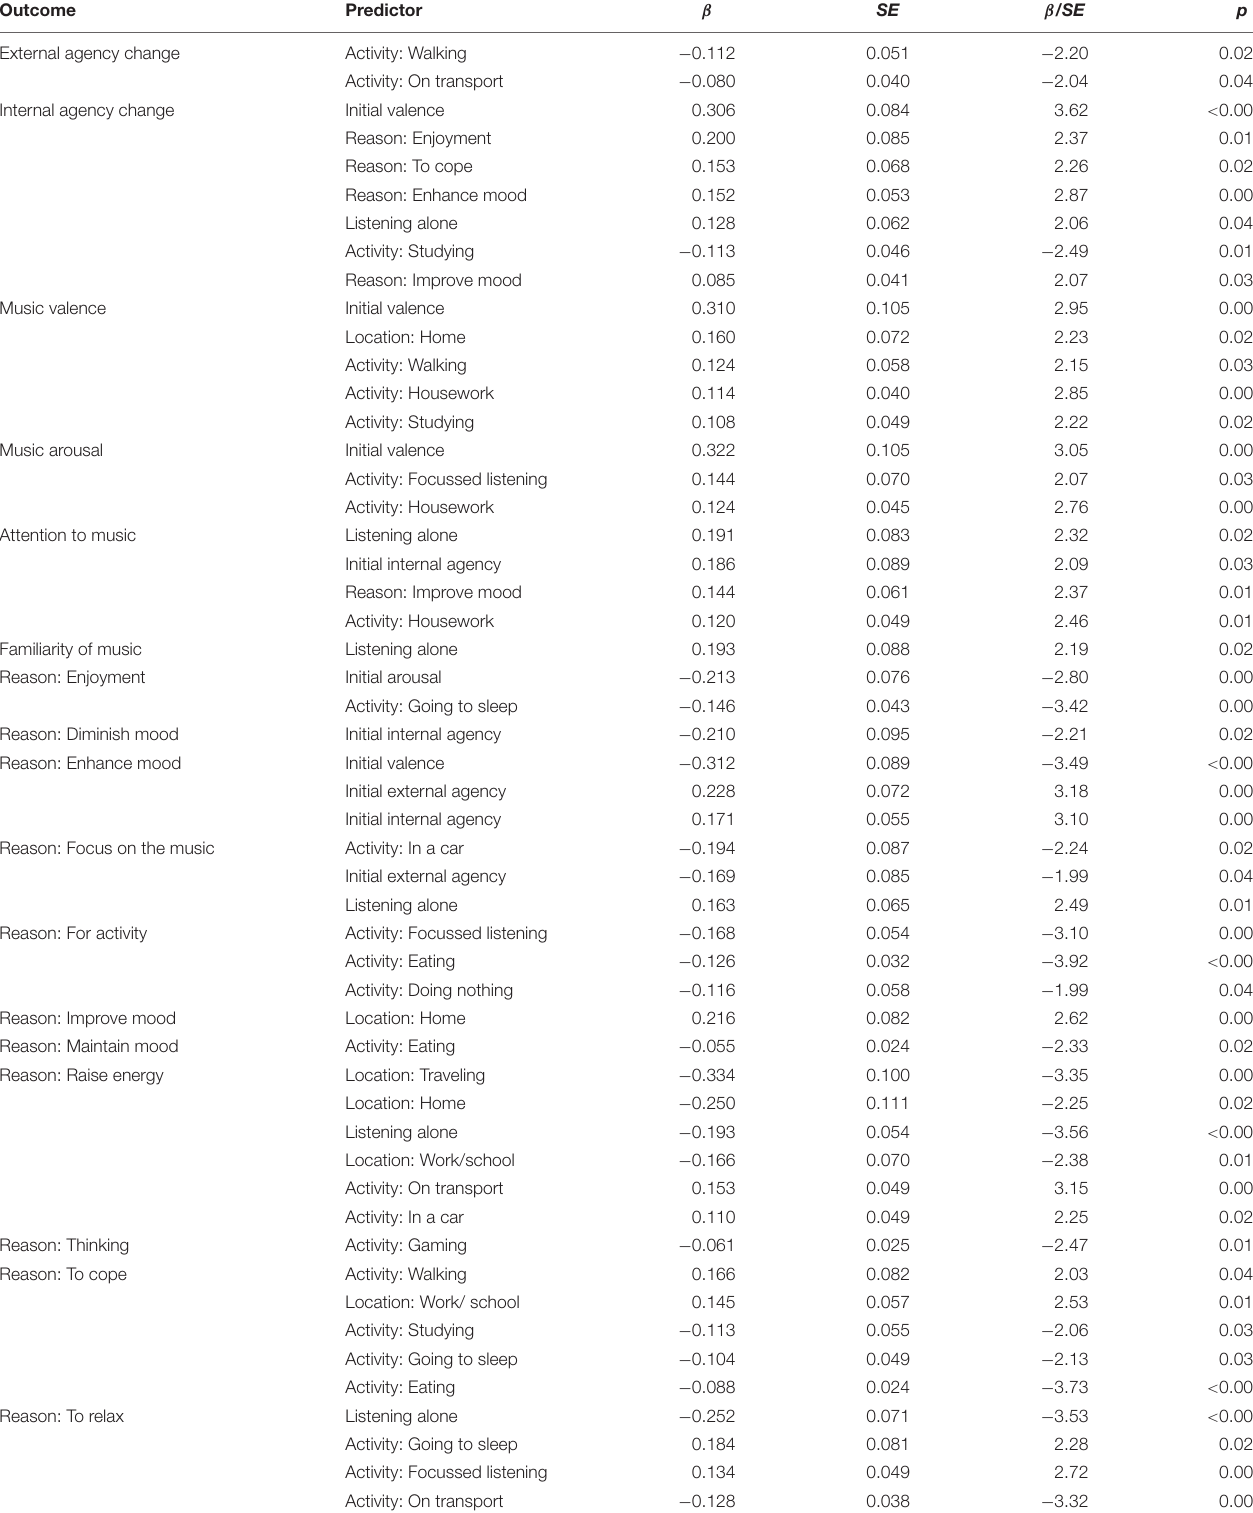
TABLE 3 | Structural equation model predictors of agency